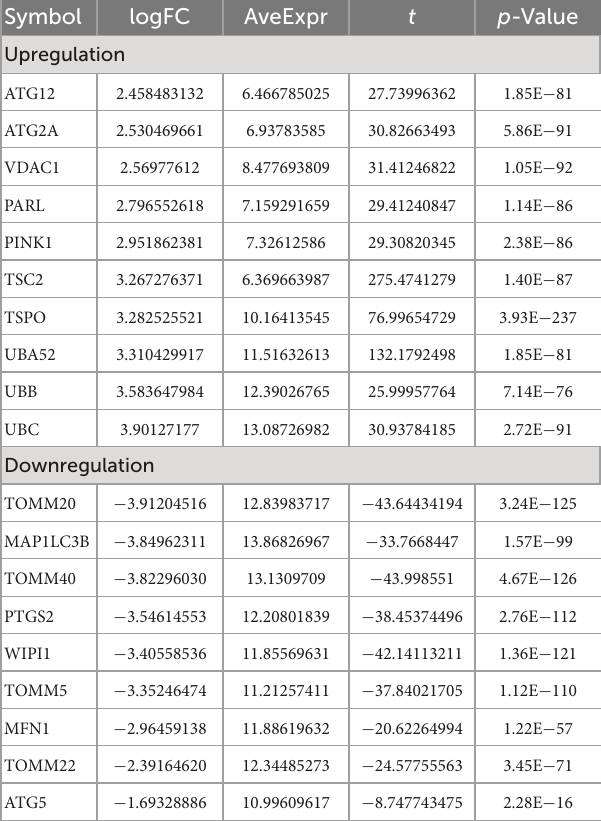
TABLE 1 Top 10 (up and downregulated) of differentially expressed mRNAs in Alzheimer disease samples and control group samples of